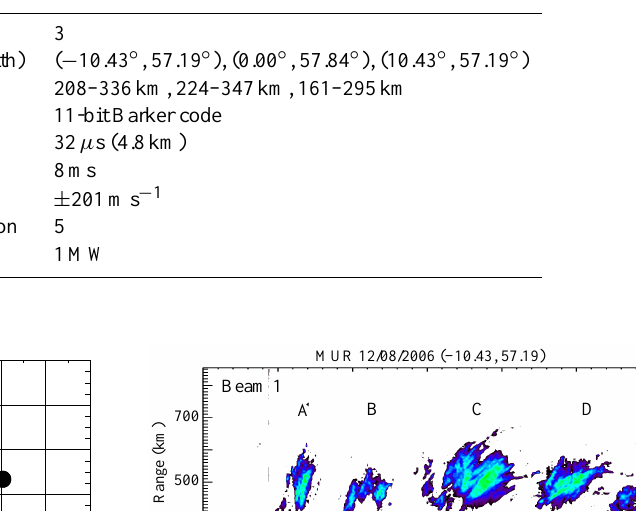
Table 1. Parameters of the MU radar observations.